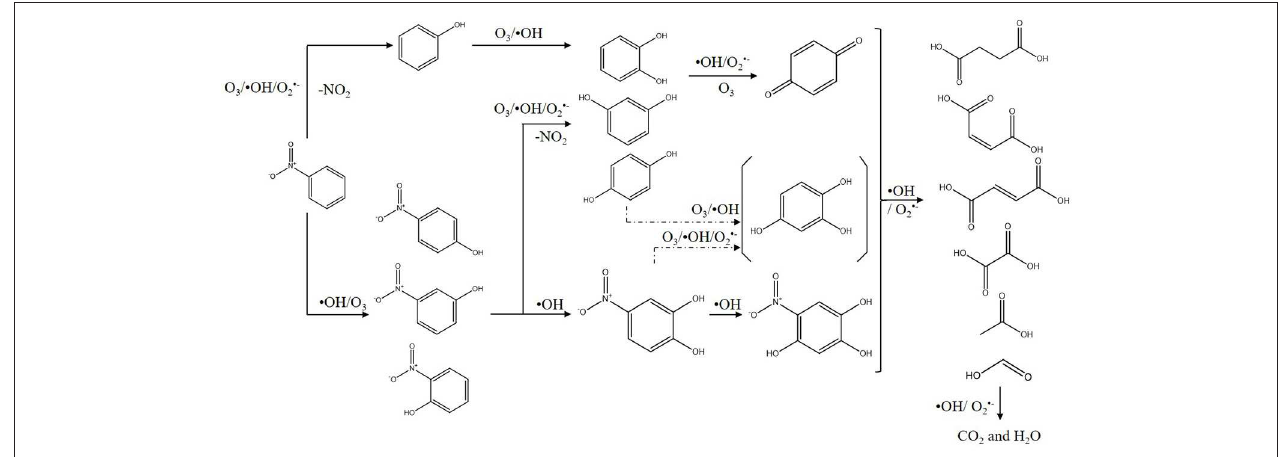
FIGURE 9 | Proposed degradation pathways of nitrobenzene using COP with Mn-USY (All compounds were detected, except the one in the parenthesis).